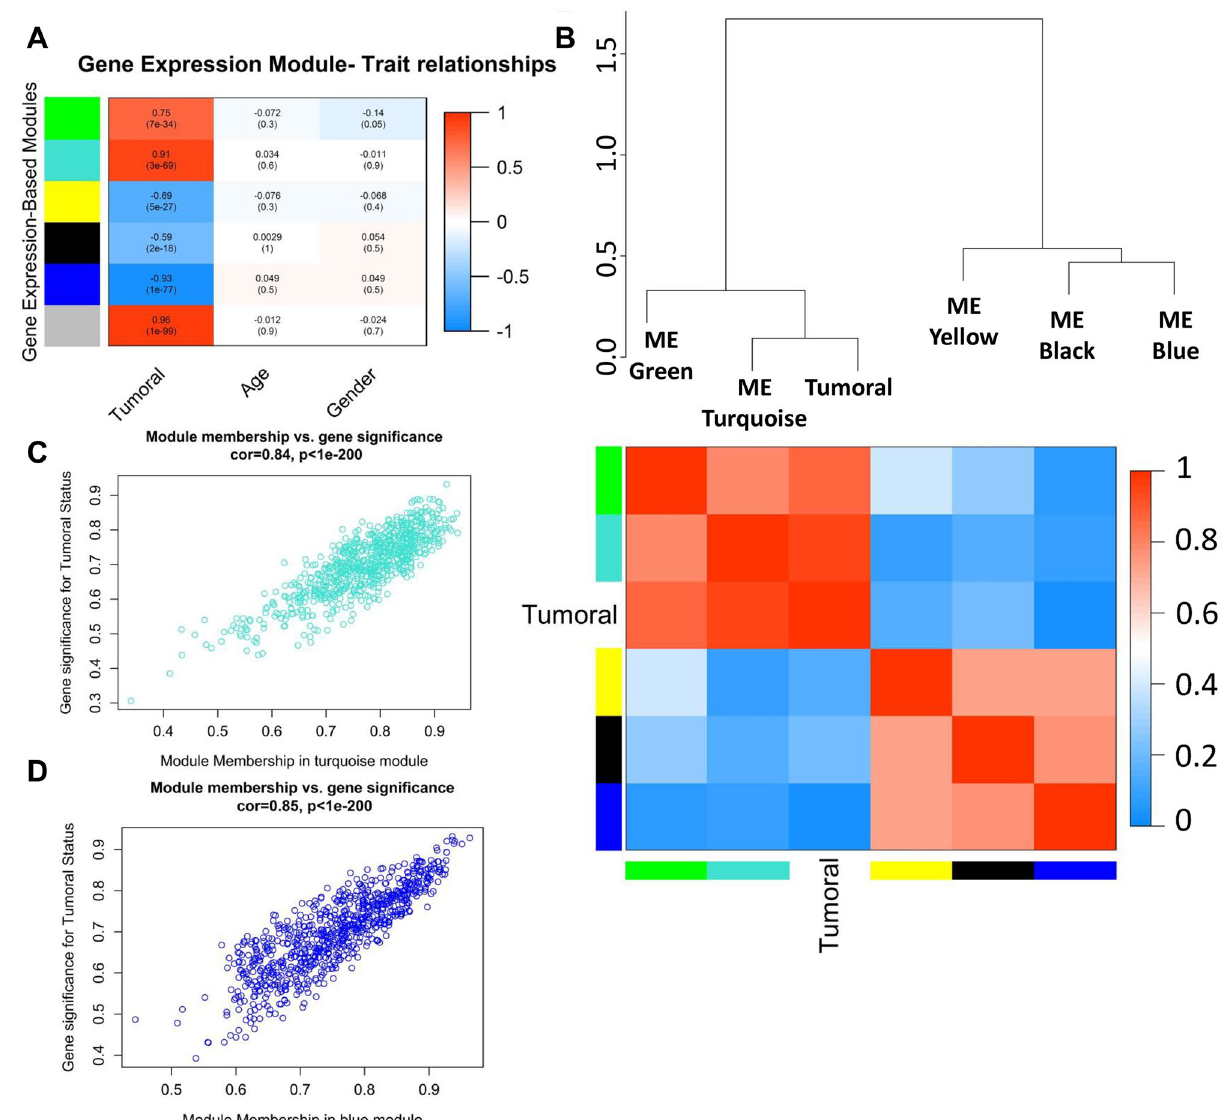
Figure 3. Gene co-expression modules correlated with colorectal cancer. ( A ) Module–trait relationships. Each cell includes the corresponding correlation and P -value. ( B ) The eigengene dendrogram and heatmap classify groups of correlated eigengenes. A scatter plot of the gene significance for Tumoral versus the module membership in the Turquoise ( C ) and Blue ( D )